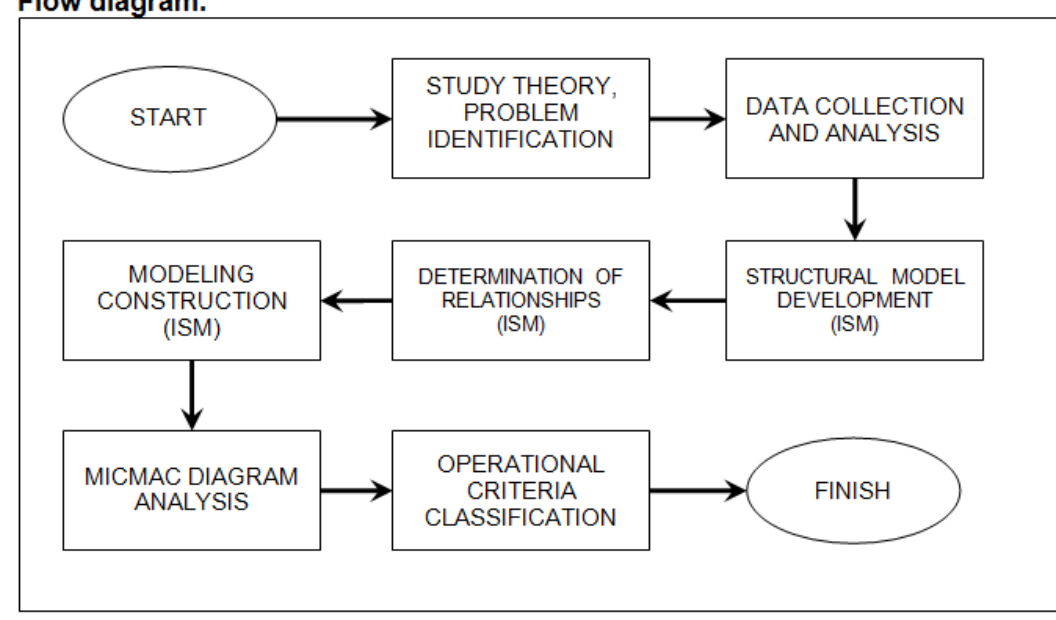
Figure 3. Research